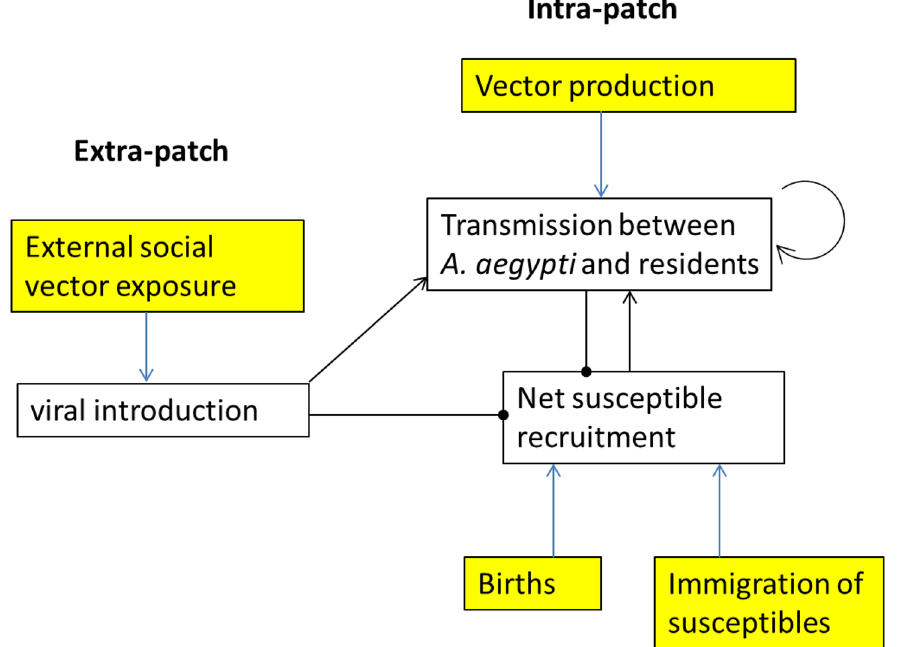
Fig 1. Schematic of dengue transmission system in an urban patch. Arrows represent causally increasing or self-enhancing effects, dots represent causally decreasing effects. For example, transmission between residents and mosquitoes on its own is self-enhancing because it amplifies the exposure of non- infected hosts to dengue. The transmission system is comprised of the interactions between the white boxes; yellow boxes are socio-ecological drivers of interest, represented as parameters in the